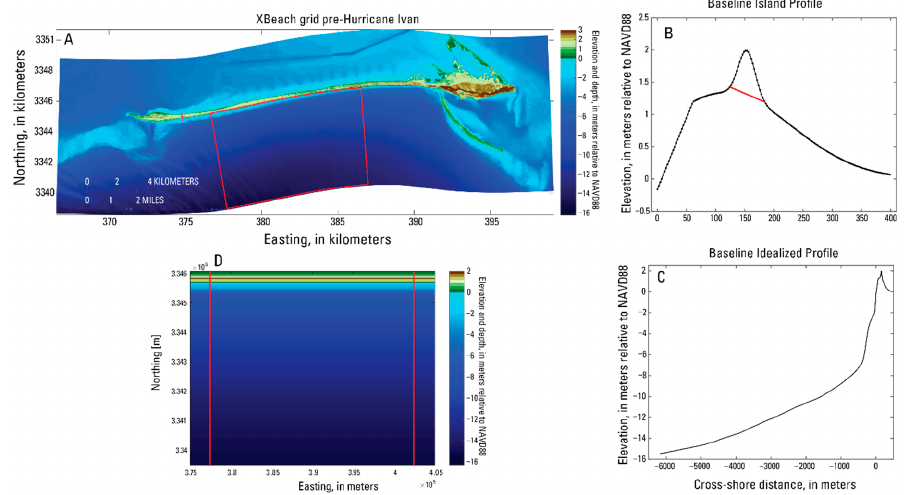
Figure 3. ( A ) Digital elevation model (DEM) of Dauphin Island from 2004, prior to Hurricane Ivan [24]. Red box indicates area used to calculate an alongshore average offshore depth profile to use in the current study. ( B ) Baseline island idealized profile generated using mean values for island, dune, and beach profile characteristics; red line indicates dune footprint area examined in post-storm analyses for dune volume and width changes. ( C ) Seamless topographic and bathymetric idealized profile generating by combining the baseline idealized island profile and alongshore averaged bathymetric profile. ( D ) Alongshore uniform 2D grid generated by replication of the idealized profile in ( C ). Area east and west of the vertical red lines were excluded from analysis because of wave shadowing effects.